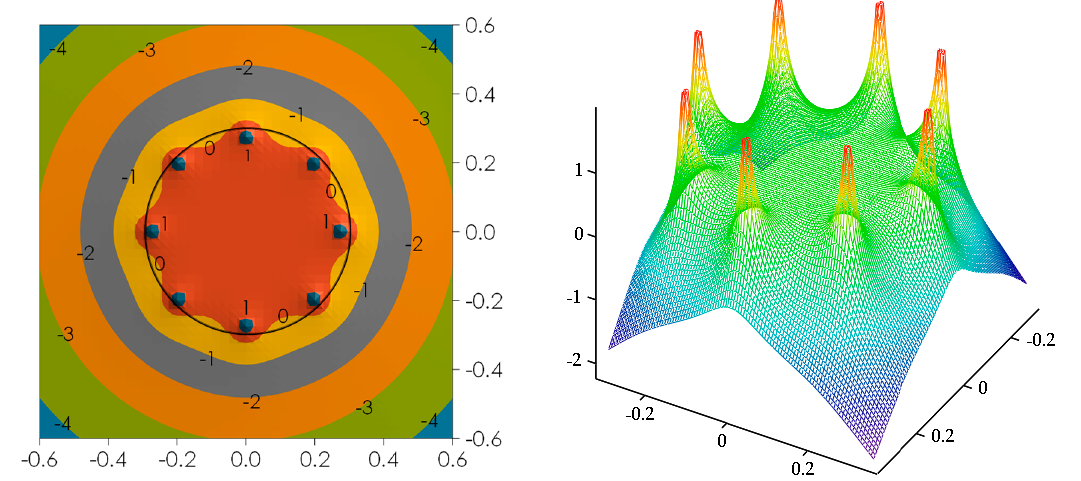
Figure 3. Temperature field ( left ) and surface plot of the temperature field ( right ) for the reference case (39).